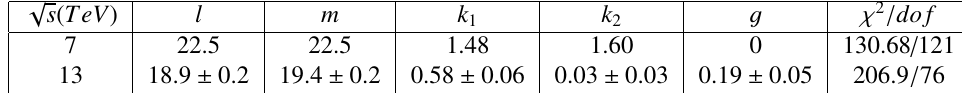
Table 1: Best fit parameters using SIMD on CMS 7TeV data and ATLAS 13TeV data. The CMS data is obtained at η < 2 . 4 while the ATLAS data is obtained for η < 2 .